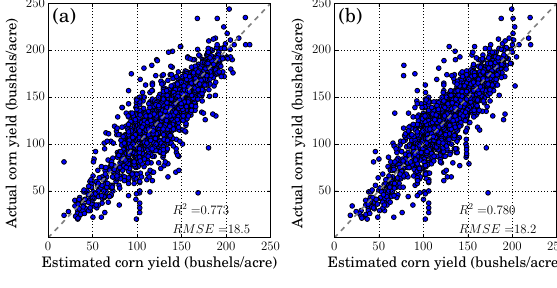
Figure 11: Corn yield estimation with deep neural network (six hidden